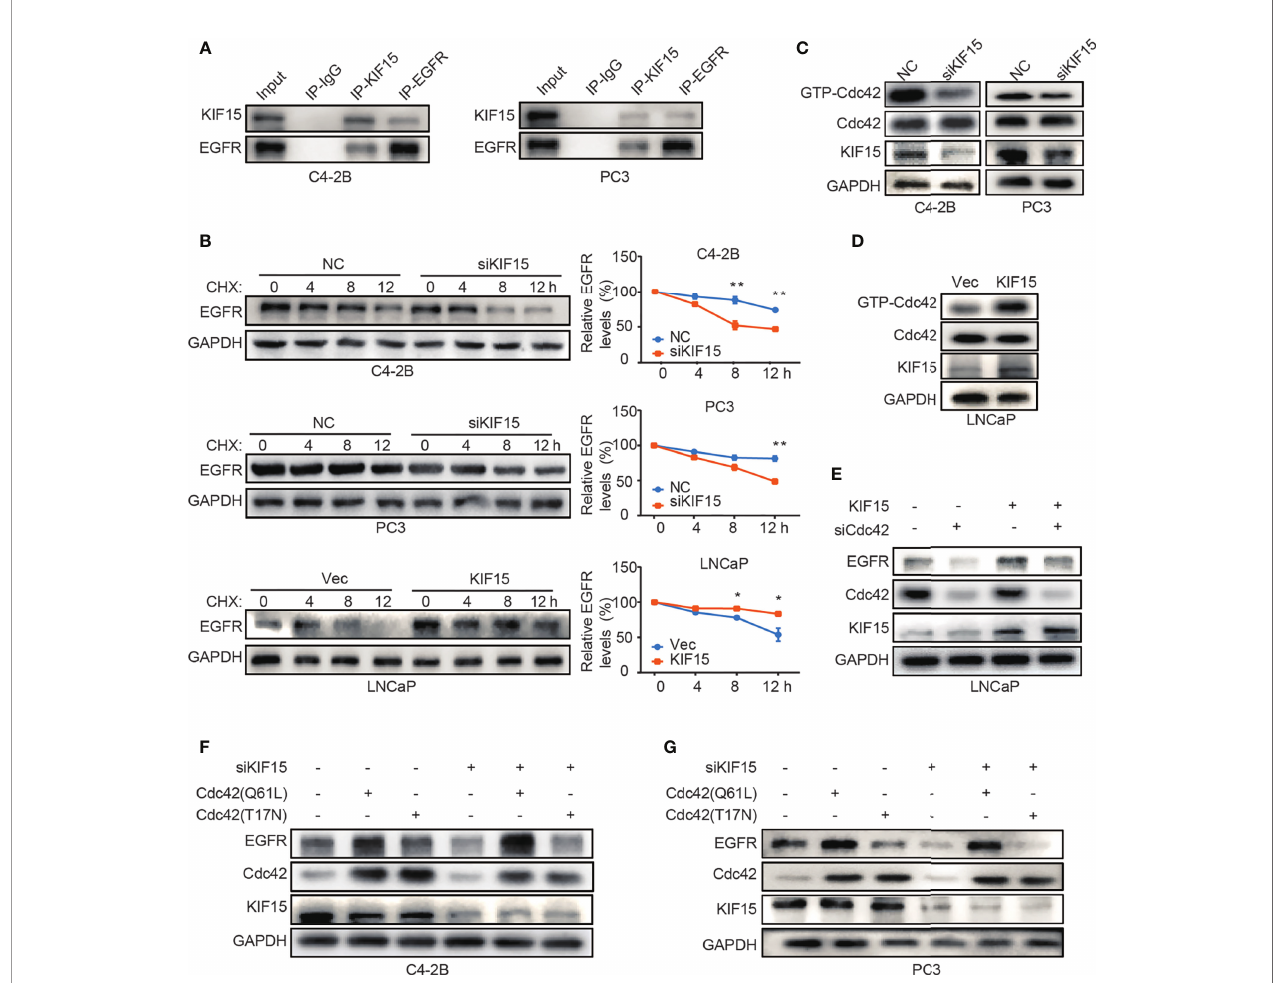
FIGURE 5 | KIF15 forms a protein complex with EGFR and inhibits EGFR degradation through Cdc42 in CRPC cells. (A) Co-IP assays performed to detect the interaction between KIF15 and EGFR in C4-2B and PC3 cells. Protein lysis was collected from C4-2B and PC3 cells to perform co-IP with control IgG or KIF15 or EGFR antibody, followed by Western blot with indicated antibodies. (B) EGFR protein levels determined by immunoblotting. C4-2B (top), PC3 (middle), and LNCaP (bottom) cells were transfected with KIF15 siRNA or KIF15 expression plasmids as indicated. At 24 hours post transfection, cells were then treated with 10 m g/ml CHX and collected at 0, 4, 8, and 12 hours. Western blot assays were performed to analyze EGFR protein levels. * P < 0.05; ** P < 0.01. (C, D) GTP-Cdc42 levels analyzed by Western blot in C4-2B, PC3 (C) , and LNCaP (D) cells with the indicated treatment. C4-2B, PC3, and LNCaP cells were transfected with KIF15 siRNA or KIF15 expression plasmids as indicated. Rho GTPase pulldown assays were performed, and activated Cdc42 (GTP-Cdc42) was measured by Western blot assay. (E – G) EGFR protein expression in LNCaP (E) , C4-2B (F) , and PC3 (G) cells with the indicated treatment. LNCaP cells were transfected with KIF15 expression plasmids and siRNA against Cdc42 (E) , while C4-2B (F) , and PC3 (G) cells were transfected with siRNA against KIF15 and Cdc42(T17N) or Cdc42(Q61L) expression plasmids for 48 hours, then were harvested and lysed for Western blot